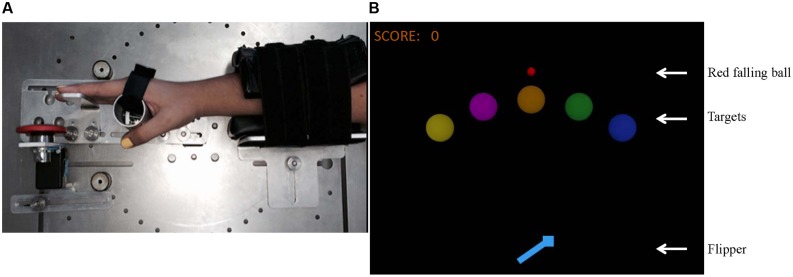
(A) The Timing Exerciser Orthosis (TEO) robot; (B) Description of the computerized pinball-like game: a red ball appears at the top of the screen and falls toward the virtual flipper. Subjects flex their right wrist to activate TEO. TEO moves the wrist at an angle of 10°, allowing the subject’s fingers to touch the button while rotating the flipper. The ball touches the flipper, and then bounces toward the target.